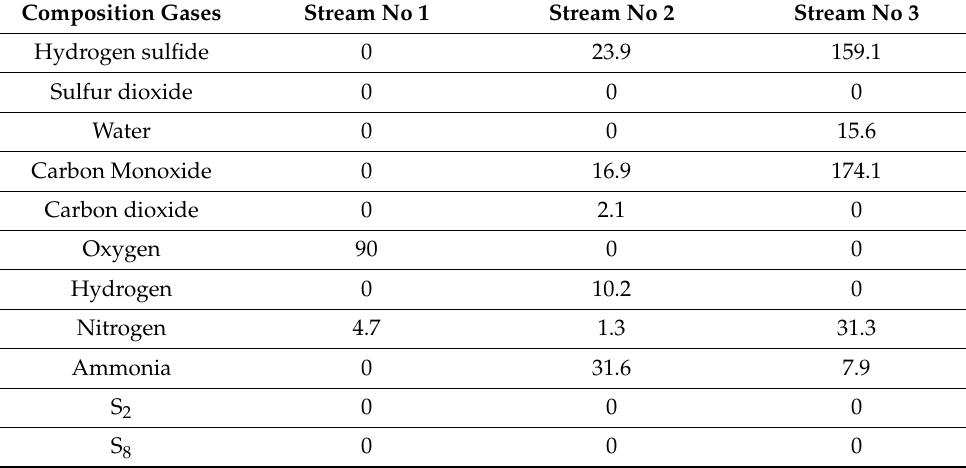
Table 1. Inlet composition of feed for three different inlet streams. Composition